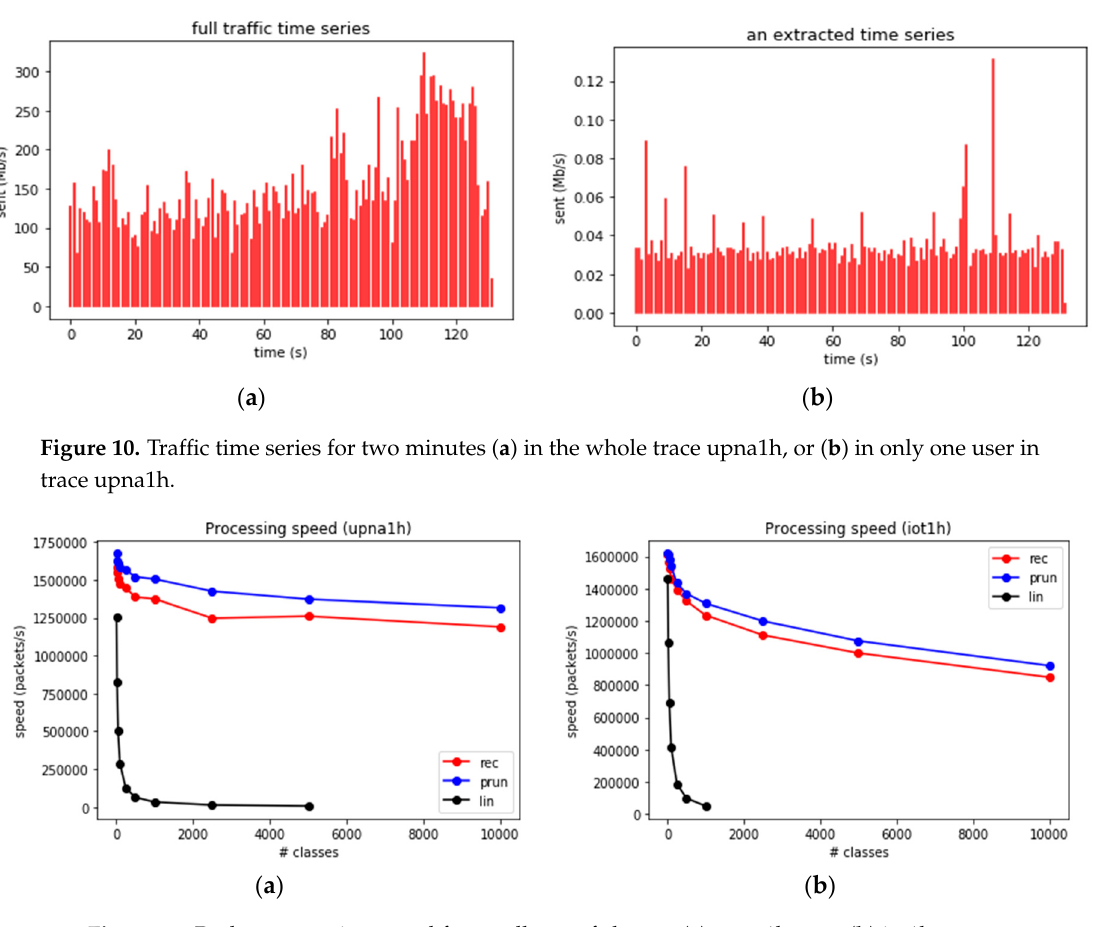
Figure 11. Packet processing speed for small sets of classes. ( a ) upna1h trace ( b ) iot1h trace.